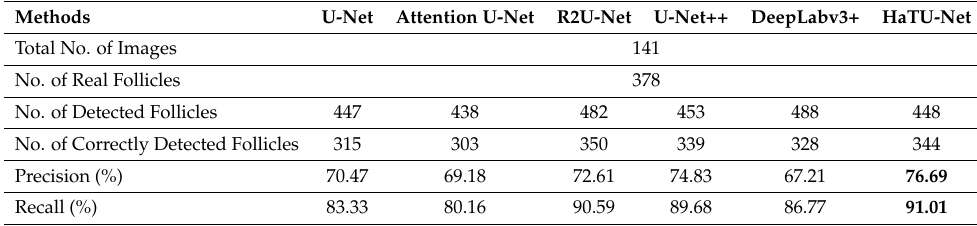
Table 6. Follicles counting results in five state-of-the-art segmentation methods.